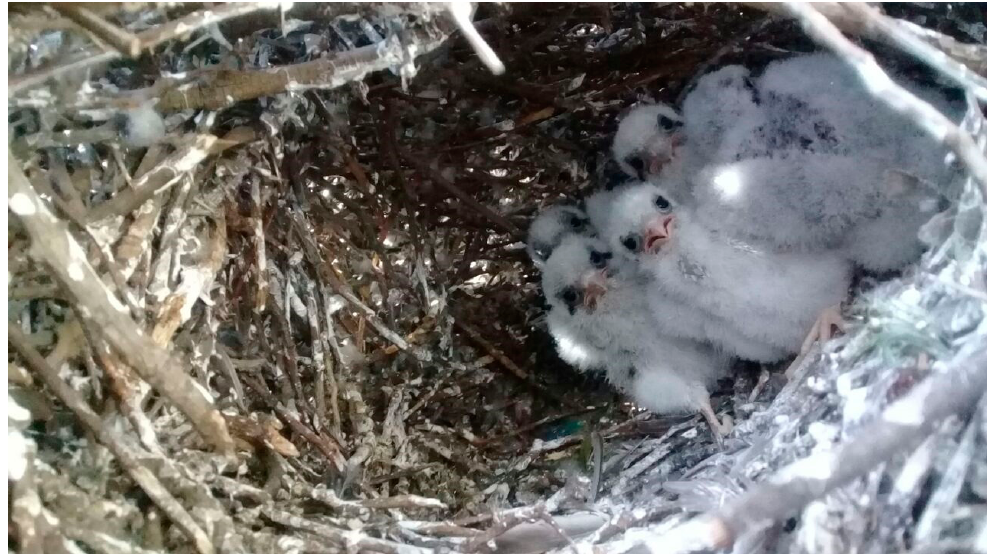
Figure 2. American kestrel ( Falco sparverius ) nestlings bred in a monk parakeet nest chamber, during the Austral spring of 2018 in Santiago, Chile.